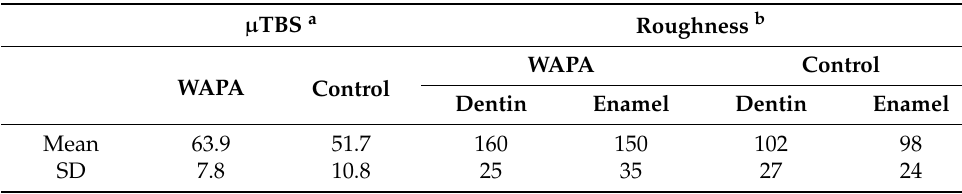
Table 1. Descriptive statistics of microtensile bond strength ( µ TBS) and roughness ( Ra ) between WAPA group (water–airborne-particle abrasion and acid-etching) and control group (only acid-etching). µ TBS a